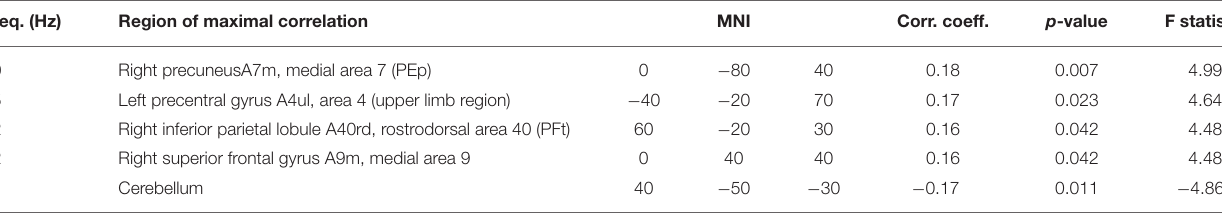
TABLE 4 | Clusters of brain activity correlating with rating of own performance. Freq. (Hz)